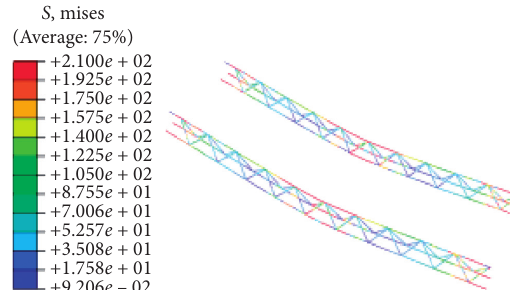
Figure 29: Cloud chart of the stress on the truss bar under ultimate load.